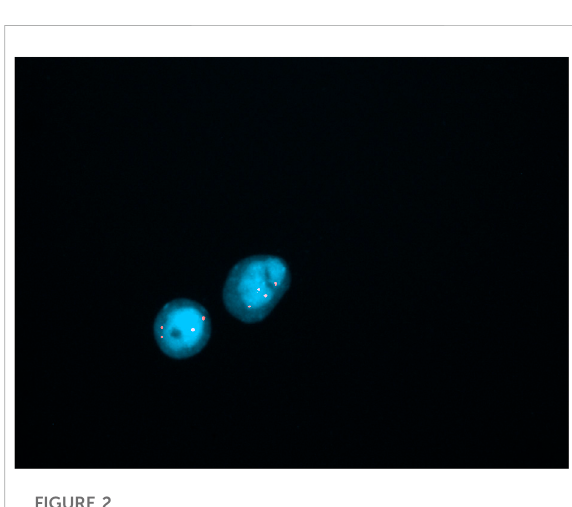
FIGURE 2 Identi fi cation of the marker chromosomes with